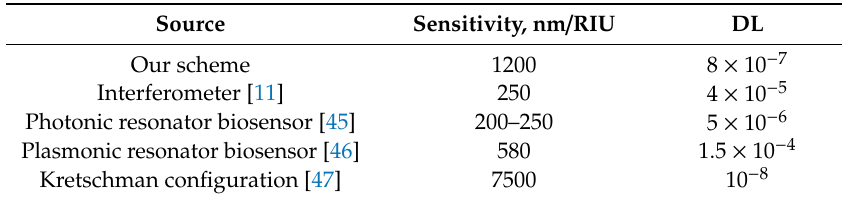
Table 1. Comparison of the sensitivity and detection limit (DL) for di ff erent types of biosensors. RIU—refractive index